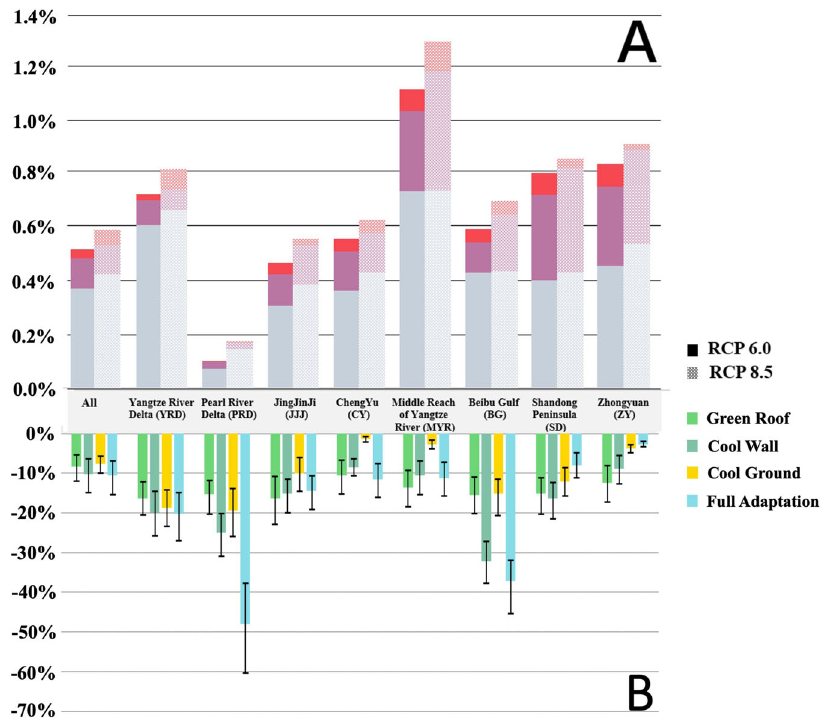
Fig. 4 Changes in the total GDP loss compared to the baseline scenario and the fraction of the economic losses that can be prevented via the implementation of adaptation strategies in all urban grids. The percentages in the upper panel ( A ) indicate the percentage increases in the economic losses due to urban warming under the RCP 6.0 and RCP 8.5 scenarios with SSP2 by the 2050s relative to the 2010s, and the three colors indicate the total contribution of the three sectors. The percentages in the lower panel ( B ) indicate the annual percentage reductions in the economic losses due to the different urban adaptation strategies (2050 – 2060) under RCP 6.0 compared to the additional increases in the economic losses in the future relative to the baseline level. Error bar refers to the standard deviation of the results from 2050 to